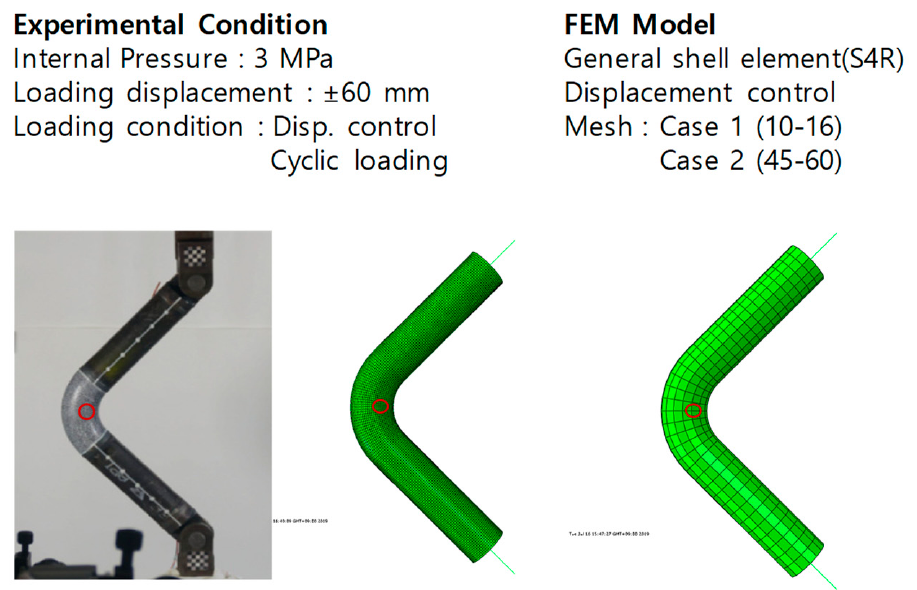
Figure 4. Finite element analysis model of the pipe specimens.